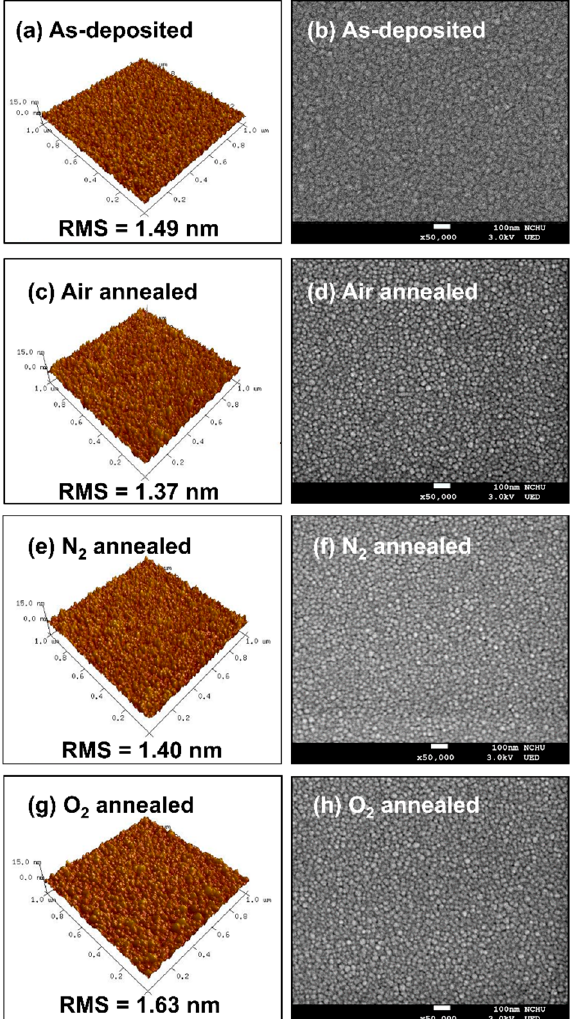
Figure 2. AFM micrographs of ( a ) as-deposited, ( c ) air annealed, ( e ) N 2 annealed, and ( g ) O 2 annealed ZnGa 2 O 4 films; SEM micrographs of ( b ) as-deposited, ( d ) air annealed, ( f ) N 2 annealed, and ( h ) O 2 annealed ZnGa 2 O 4 films.